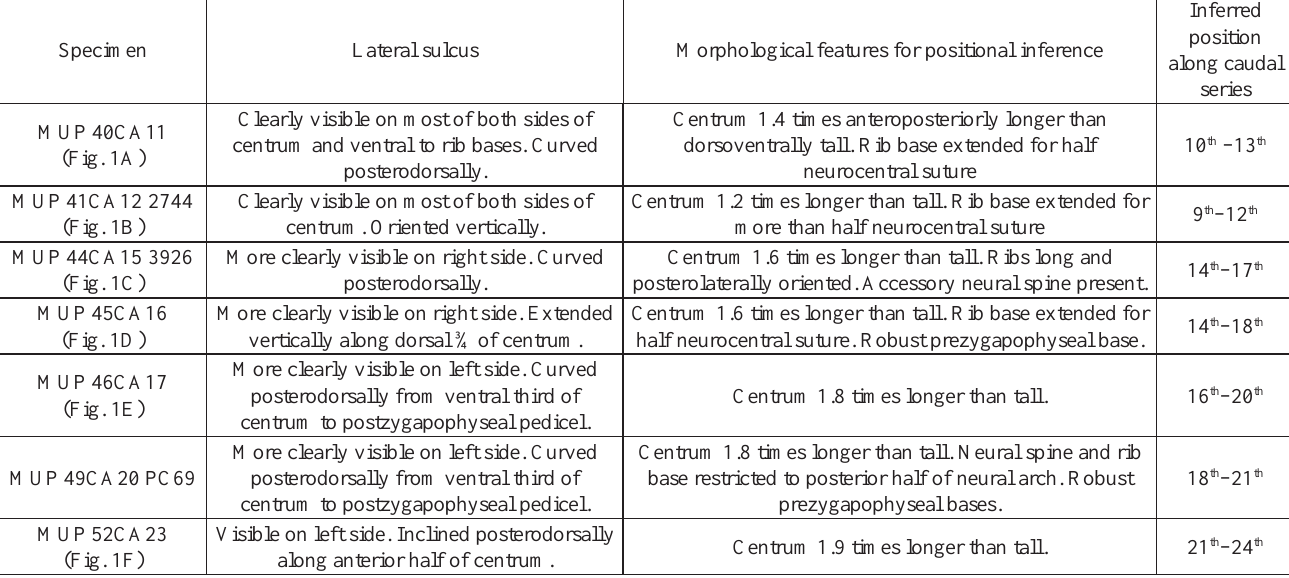
Visible on left side. Inclined posterodorsally along anterior half of centrum.